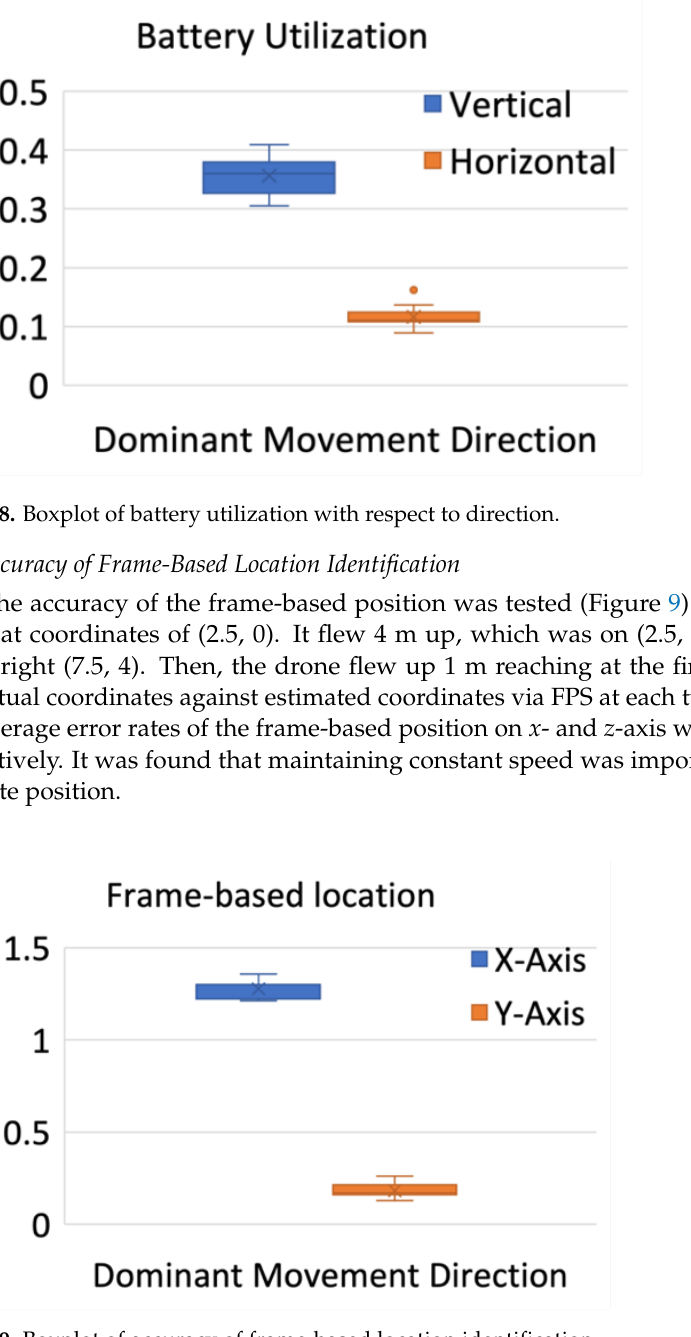
Figure 9. Boxplot of accuracy of frame-based location identification.